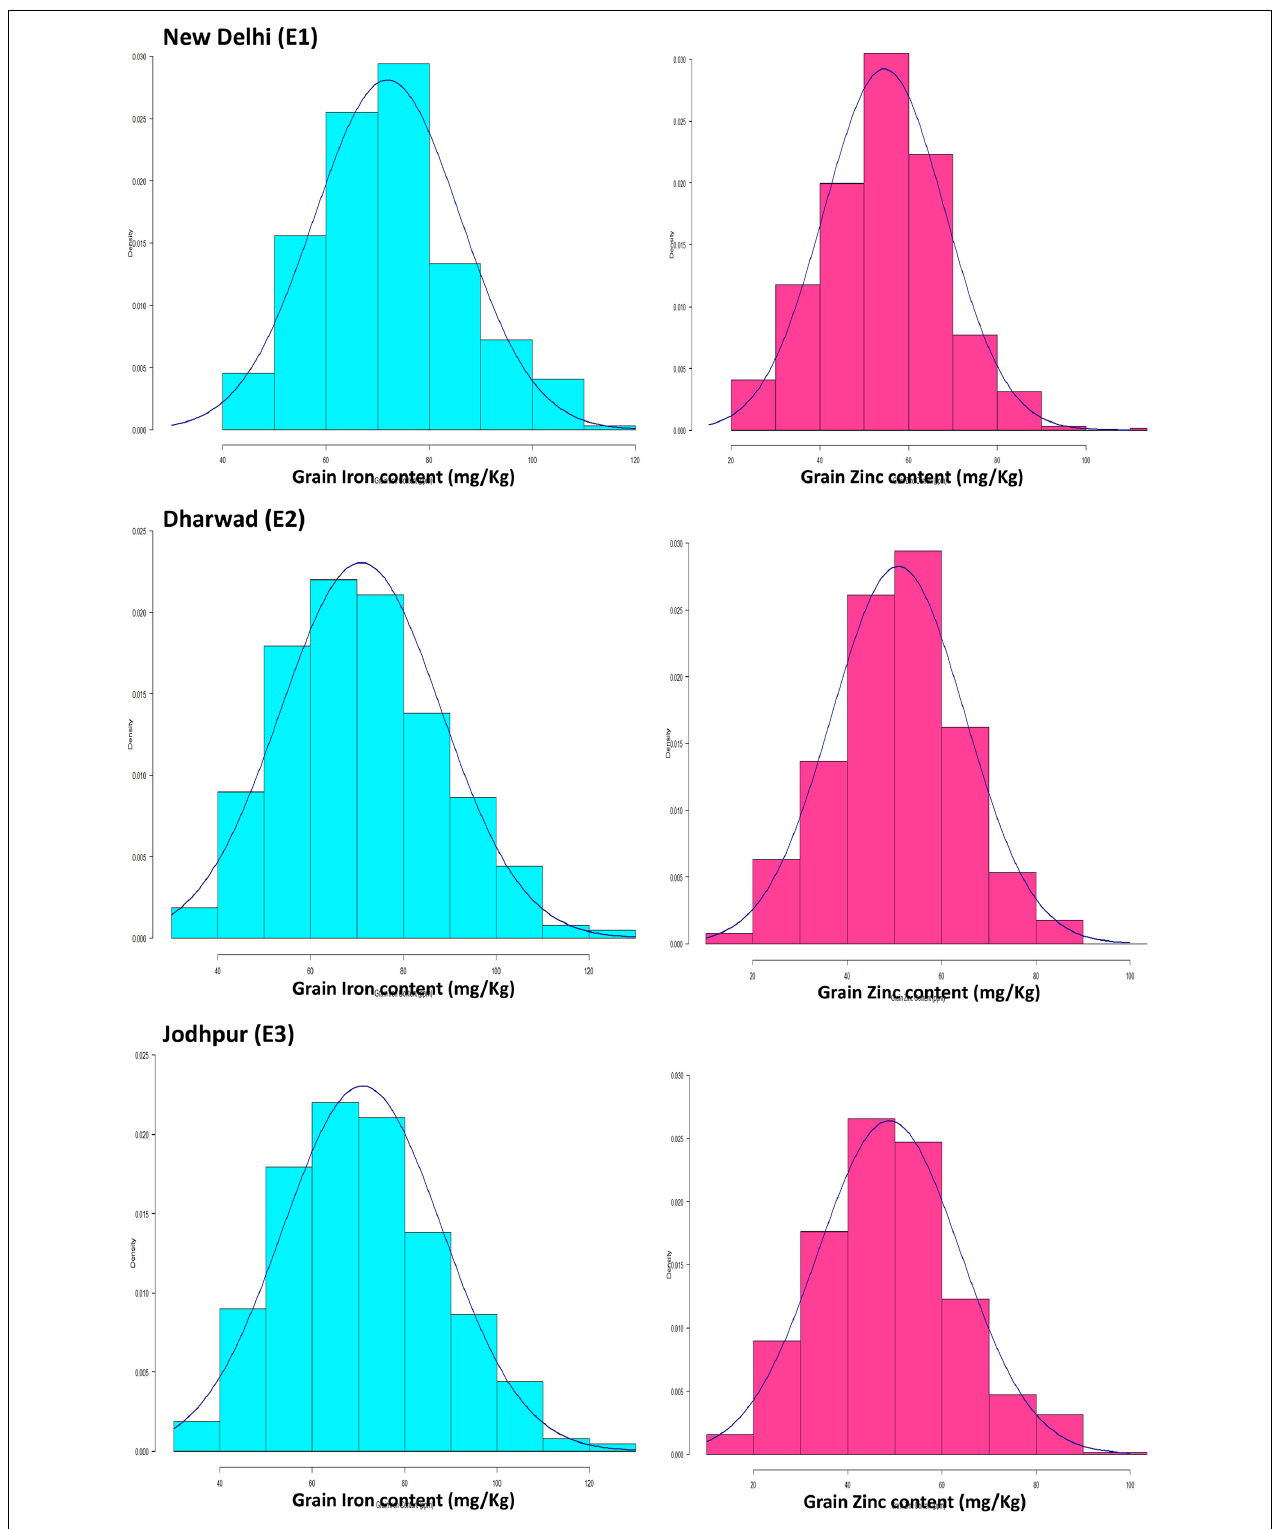
FIGURE 1 | Histograms of grain Fe and Zn in mapping populations of recombinant inbred lines evaluated across the year (2014–2016) at Delhi, Dharwad, and Jodhpur location.